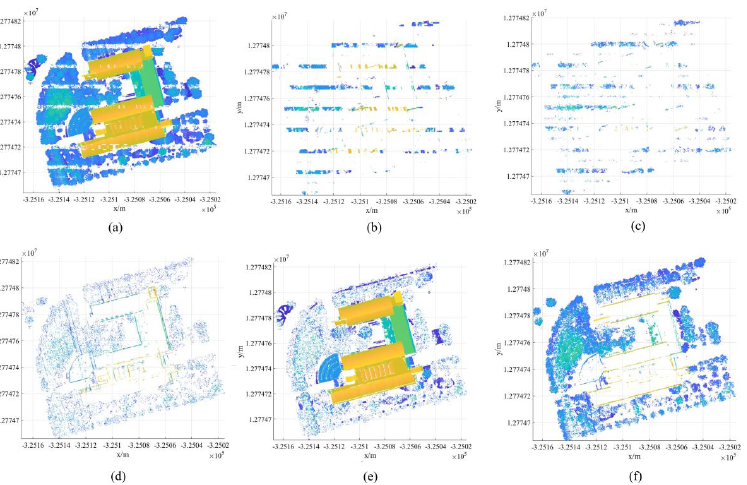
Figure 4. The feature extraction results of K -neighborhood and R -neighborhood of plot 1. ( a ) Characteristic of linearity of K -nearest neighbors; ( b ) Characteristic of planarity of K -nearest neighbors; ( c ) Characteristic of dispersion of K -nearest neighbors; ( d ) Characteristic of linearity of R -nearest neighbors; ( e ) Characteristic of planarity of R -nearest neighbors; ( f ) Characteristic of planarity of R -nearest neighbors.